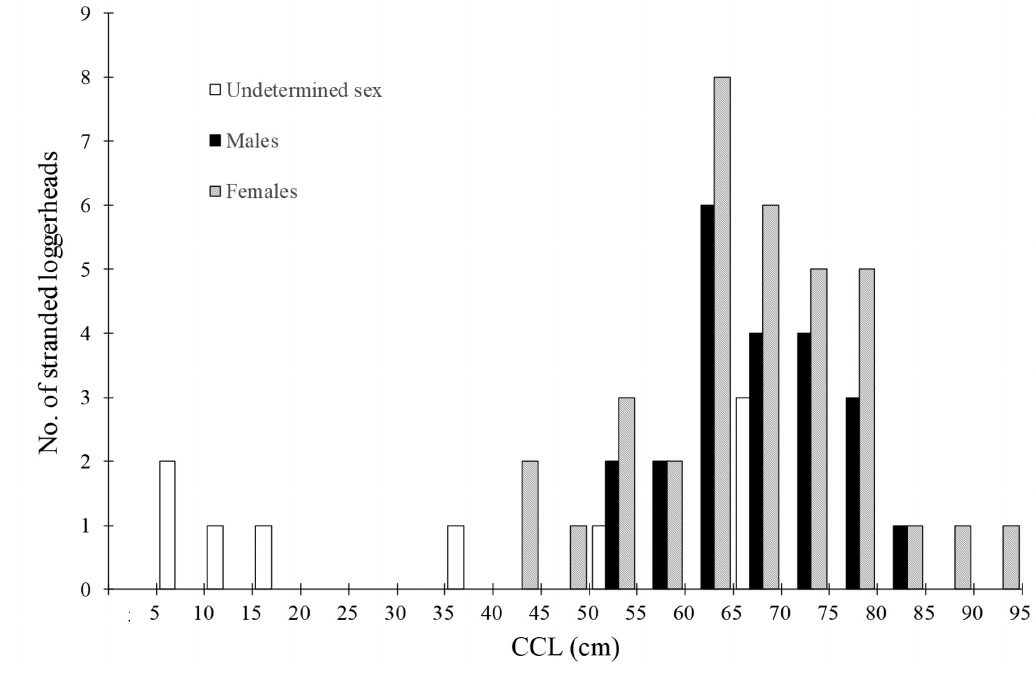
Figure 2. Body size (CCL, in cm) distribution of sampled C. caretta